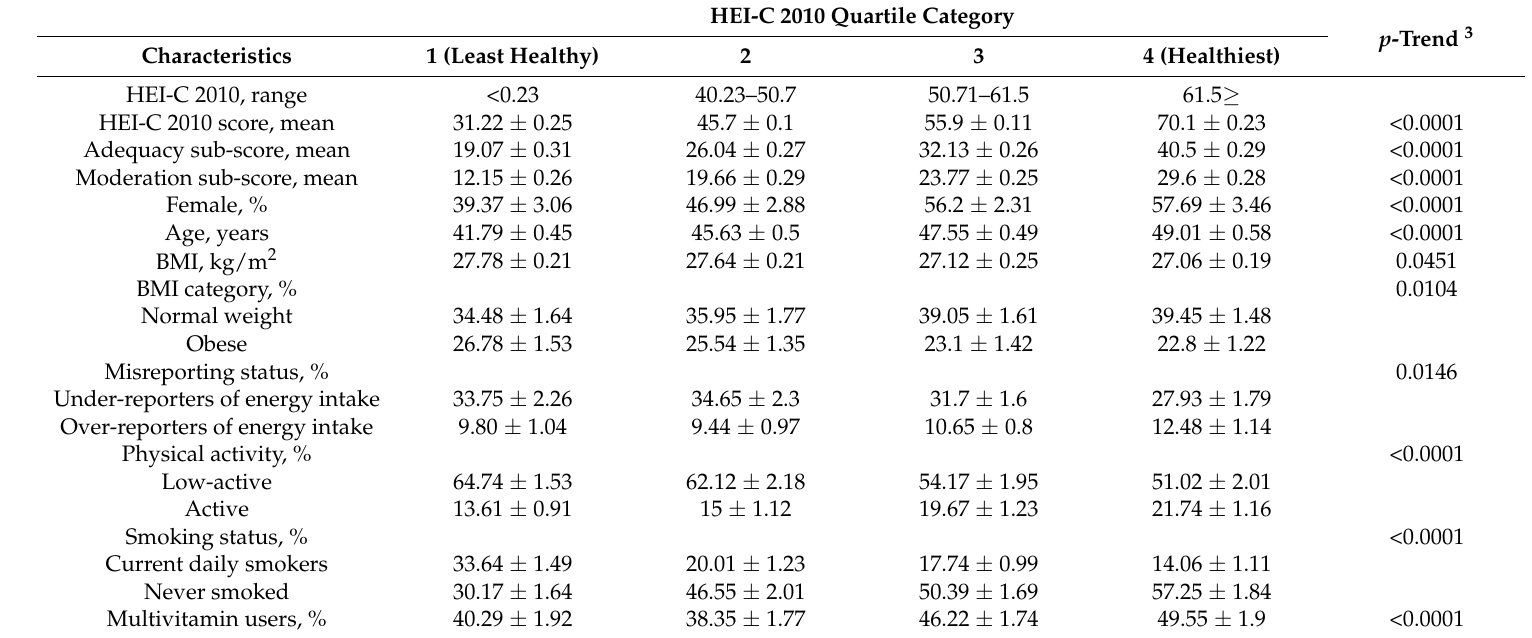
Table 1. Weighted socio-demographic and lifestyle characteristics by quartile category of the HEI-C 2010 among Canadian adults ( n = 12,805) 1,2